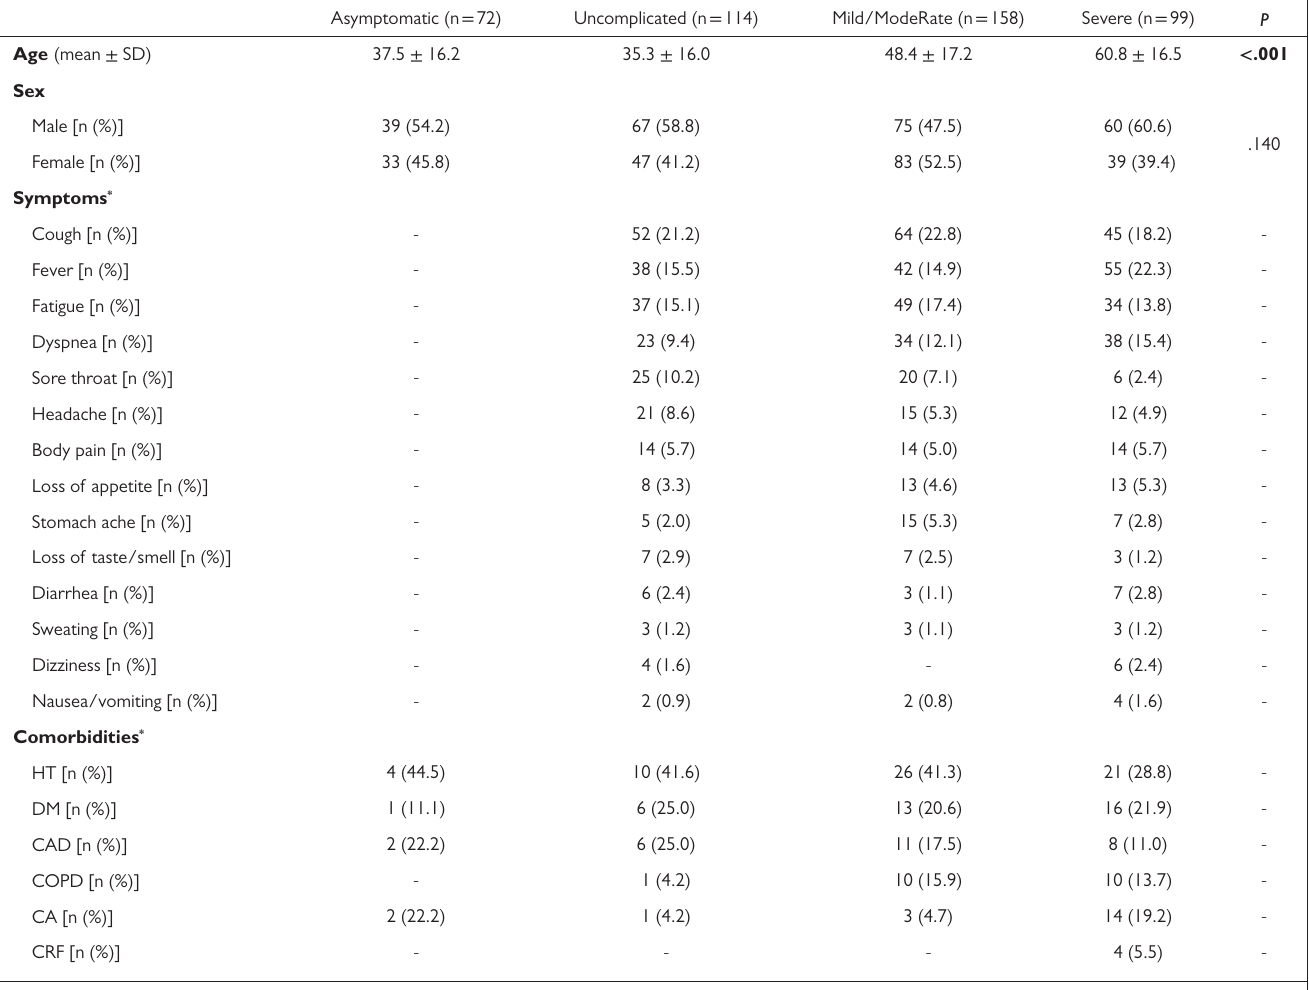
Table 1. Some Demographic Characteristics, Distribution of Symptoms, and Comorbidities of Cases According to Clinical Classification Asymptomatic (n =